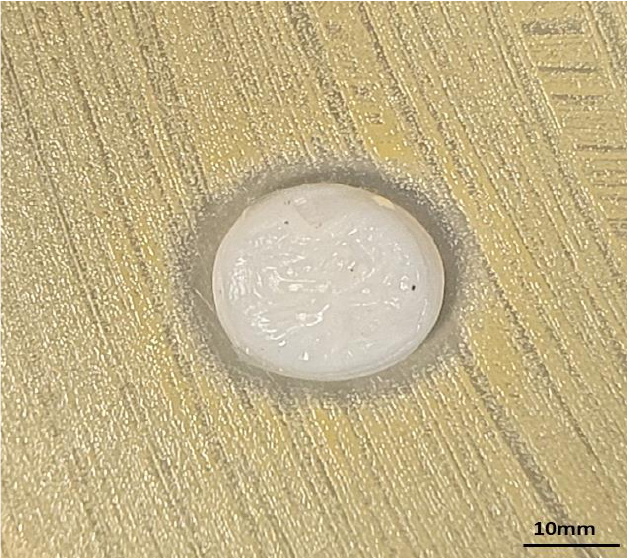
Figure 5. The inhibition of staphylococcal growth zone resulting from release of PUB9 from BC carrier in modified disk-diffusion model. The diameter of BC carrier is 18 mm.